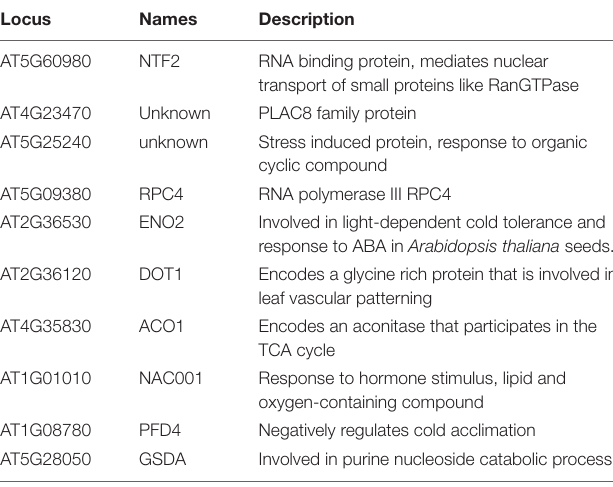
TABLE 1 | Yeast two hybrid (Y2H) screen for Transition zone1 (TZ1) interacting proteins.